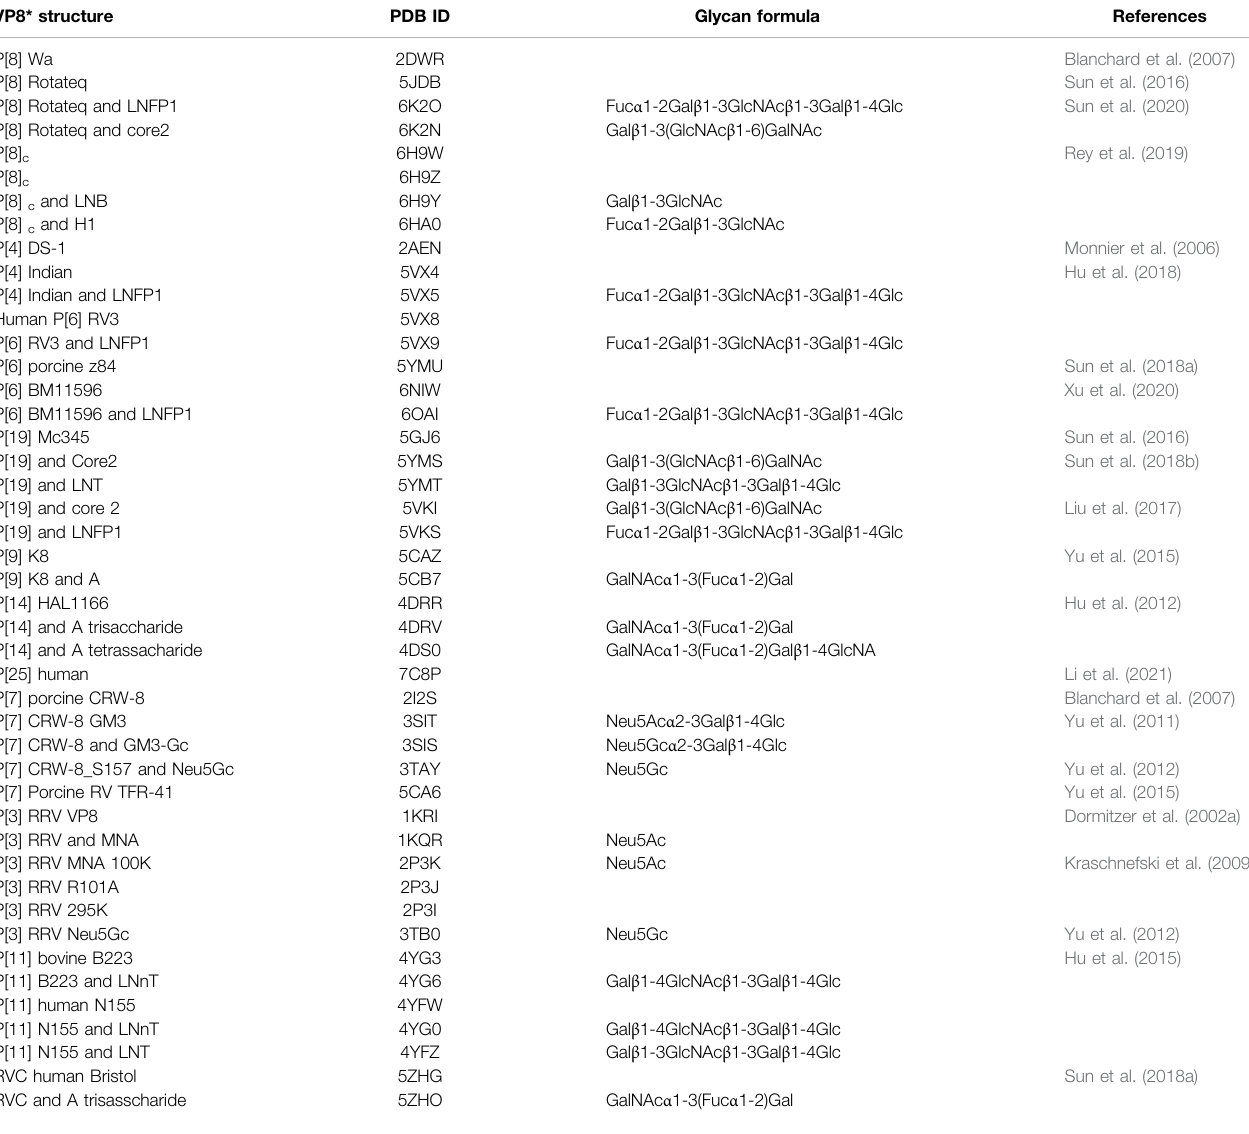
TABLE2| SummaryofVP8*andVP8*-glycanstructures.ThePDBID,glycanformula,andreferencesareincluded.Gal,yellow;GlcNAc,blue;GalNAc,green;Glc,magenta; Fuc,